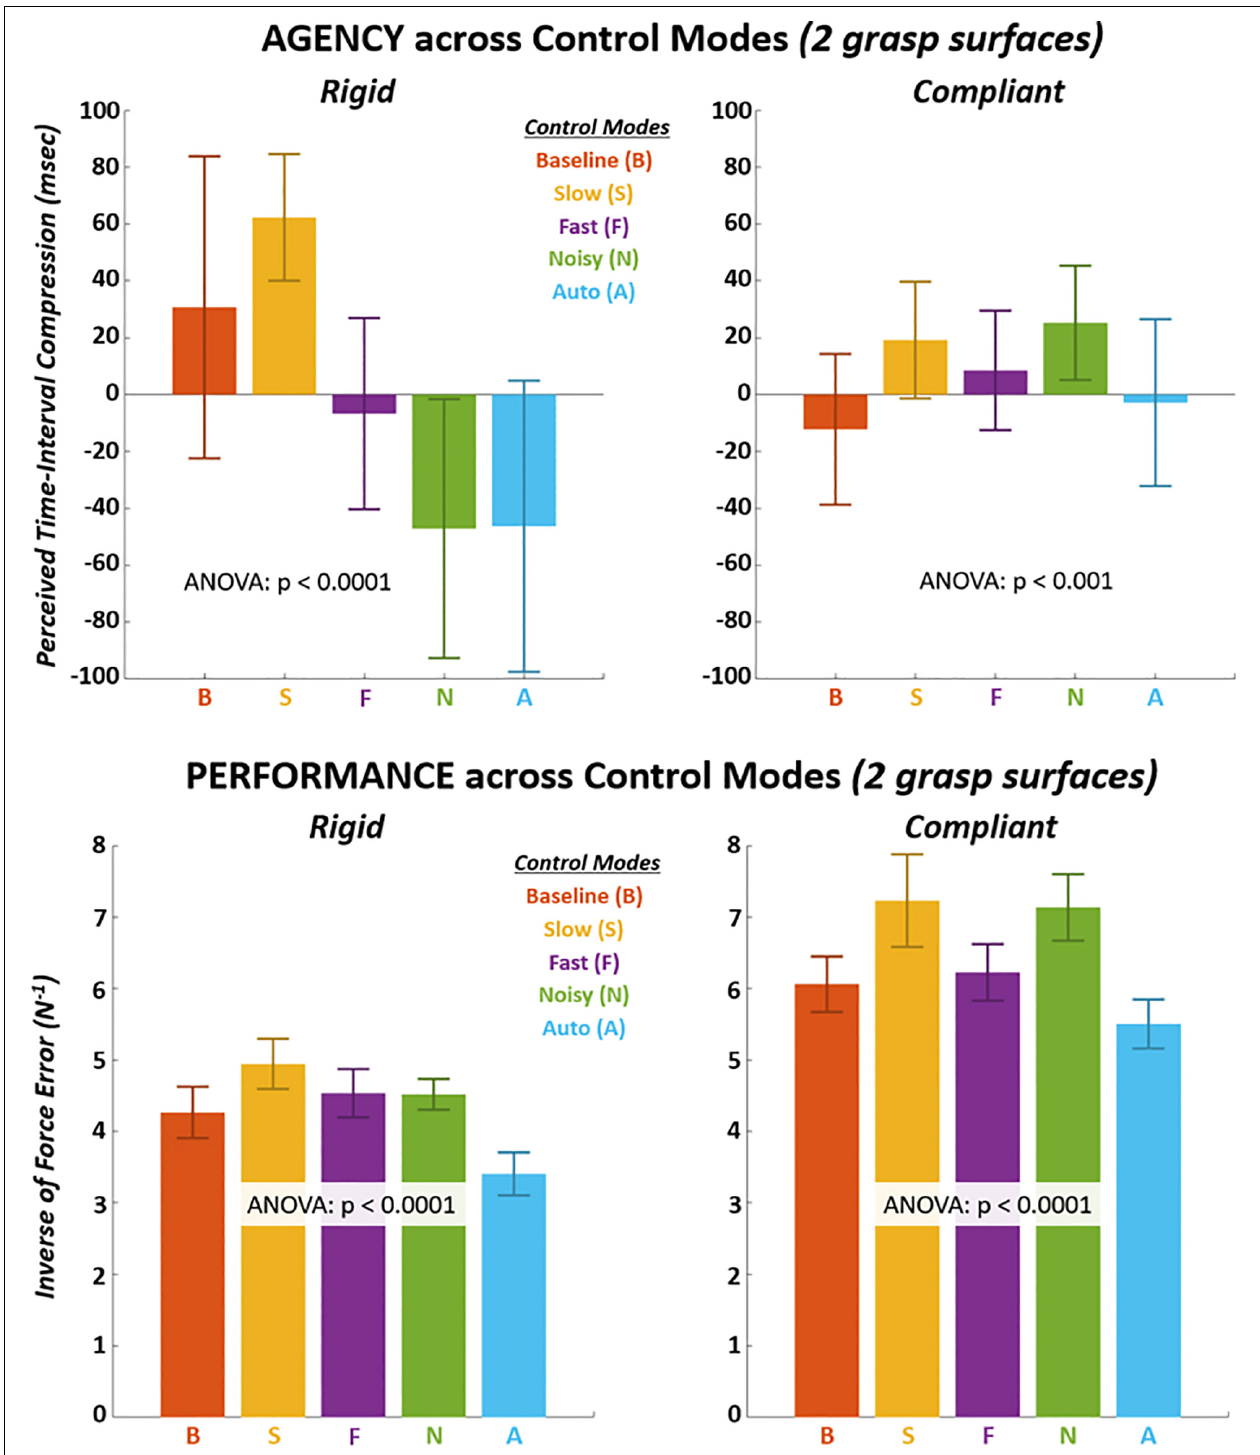
FIGURE 5 | TOP – Mean implicit agency shown for each control mode on each grasp surface. Implicit agency positively measured as underestimation of time-intervals between completion of ramp task and subsequent sound beep. BOTTOM – Mean performance shown for each control mode on each grasp surface. Performance positively measured as inverse of average tracking error to target force